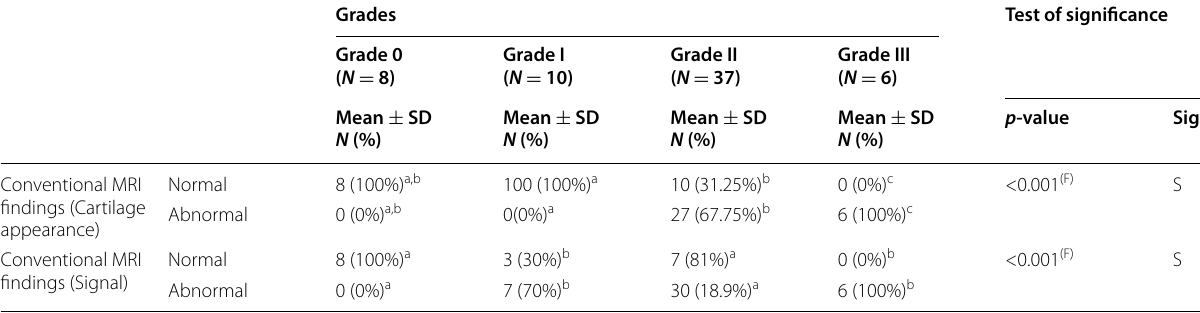
Post-hoc Tukey test was significant: -Grade 0 versus Grade I, II & III. Grade I versus Grade III Each subscript letter denotes a subset of Group categories whose column proportions do not differ significantly from each other at the .05 level F Fisher’s Exact test of significance A One Way ANOVA test of